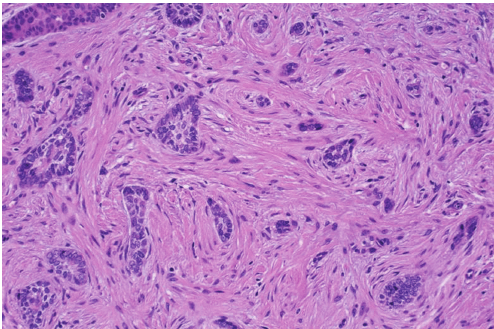
Figure 4: Microphotographs of morpheaform BCC (HE staining). Morpheaform BCC is characterized by its deep invasion of the dermis. The overlying skin surface may be atrophic, ulcerated, or relatively normal in